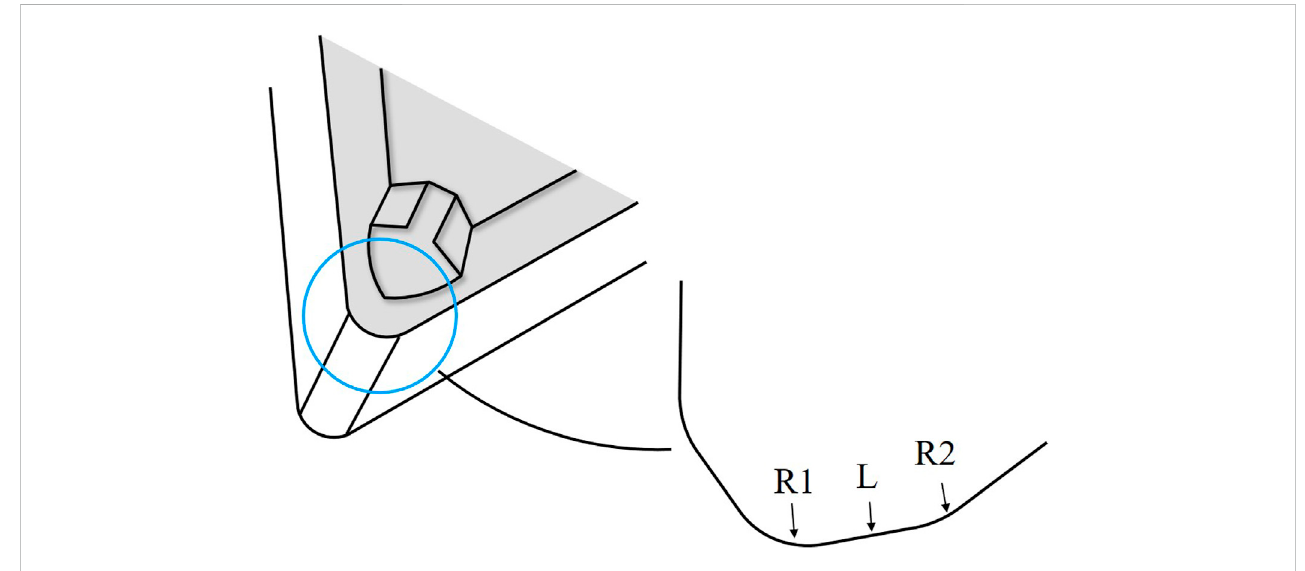
FIGURE 7 Parameters of proposed cutting tool for low-frequency vibration.